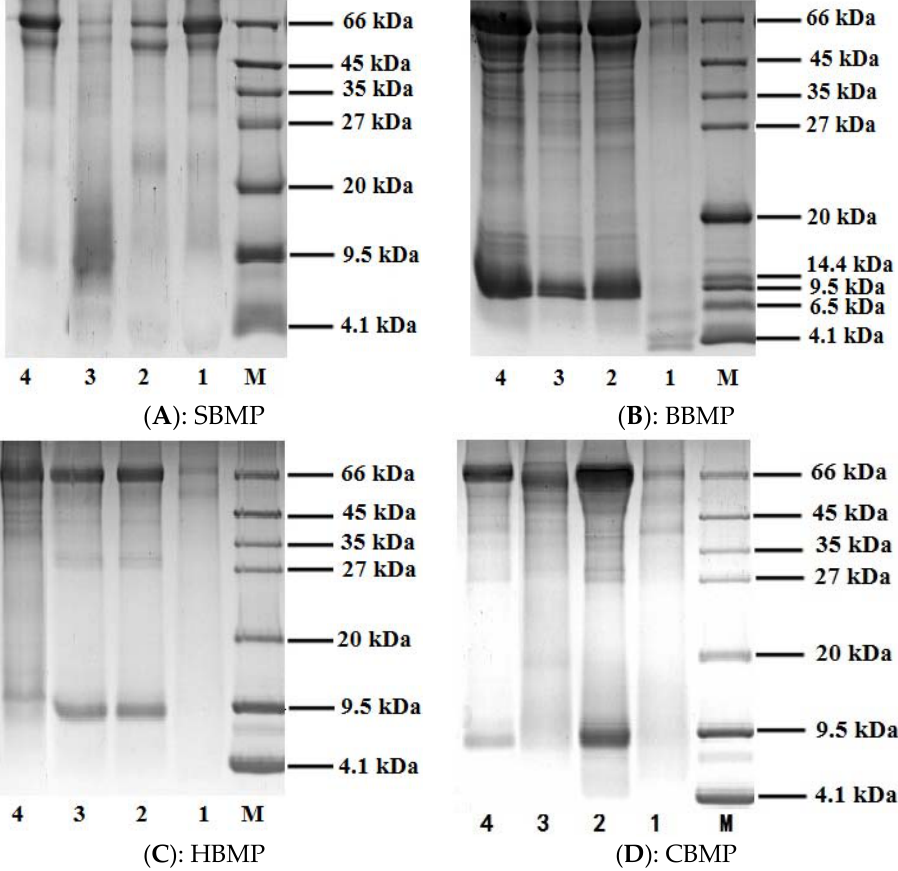
Figure 1. SDS ‐ PAGE (12%) analysis of BMP from four kinds of animals. 1: 30% of ammonium sulphate precipitation part; 2: 50% of ammonium sulphate precipitation part; 3: 70% of ammonium sulphate precipitation part; 4: water extract; M: Marker (4.1–66 kDa).